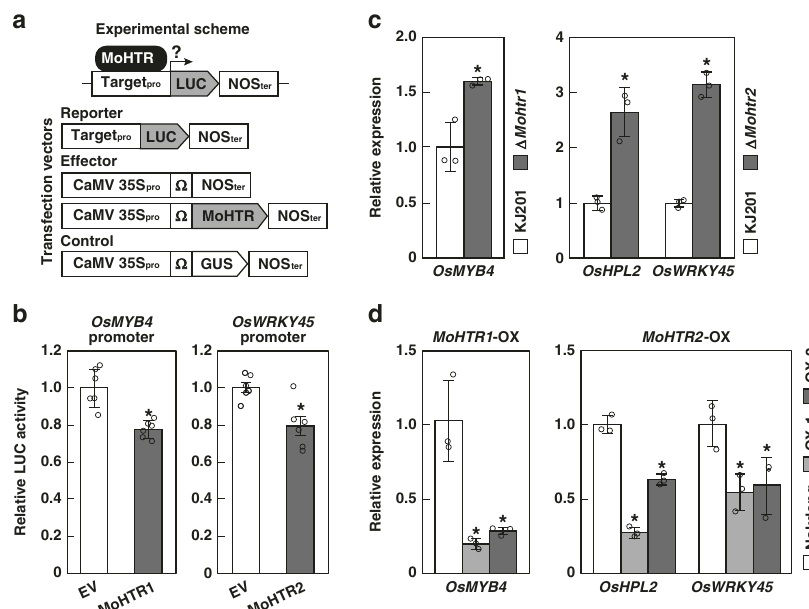
Fig. 4 Transcriptional regulation of rice genes targeted by MoHTR1 and MoHTR2. a Features of the constructs used to determine how MoHTR1 and MoHTR2 affect the expression of LUC under each rice gene promoter tested in rice protoplasts. MoHTR1 - Δ sp and MoHTR2 - Δ sp were expressed using the CaMV 35S promoter and the translation enhance sequence Ω . b Relative LUC activities in protoplasts transfected with MoHTR1 - Δ sp and MoHTR2 - Δ sp were compared with those transfected with the empty vector (EV). n = 6 independently transfected protoplasts; mean ± SD; * P < 0.01, two-sided Student ’ s t-tests. Three biological replicates produced similar results. c Expression patterns of the selected target genes in rice individually infected with Δ MoHTR1 and Δ MoHTR2 were compared with those in rice infected with KJ201. Mean ± SD, three independent experiments; * P < 0.01, two-sided Student ’ s t -tests. d Expression levels of individual target genes in MoHTR1 -OX and MoHTR2 -OX were compared with those in Nakdong (wild type) using qRT-PCR. Mean ± SD, three independent experiments; * P < 0.05, one-way analysis of variance (ANOVA) with Tukey ’ s honest signi fi cant difference (HSD) test. Detailed information about biological repeat experiments and statistical analysis underlying Fig. 4b – d are described as a Source Data fi